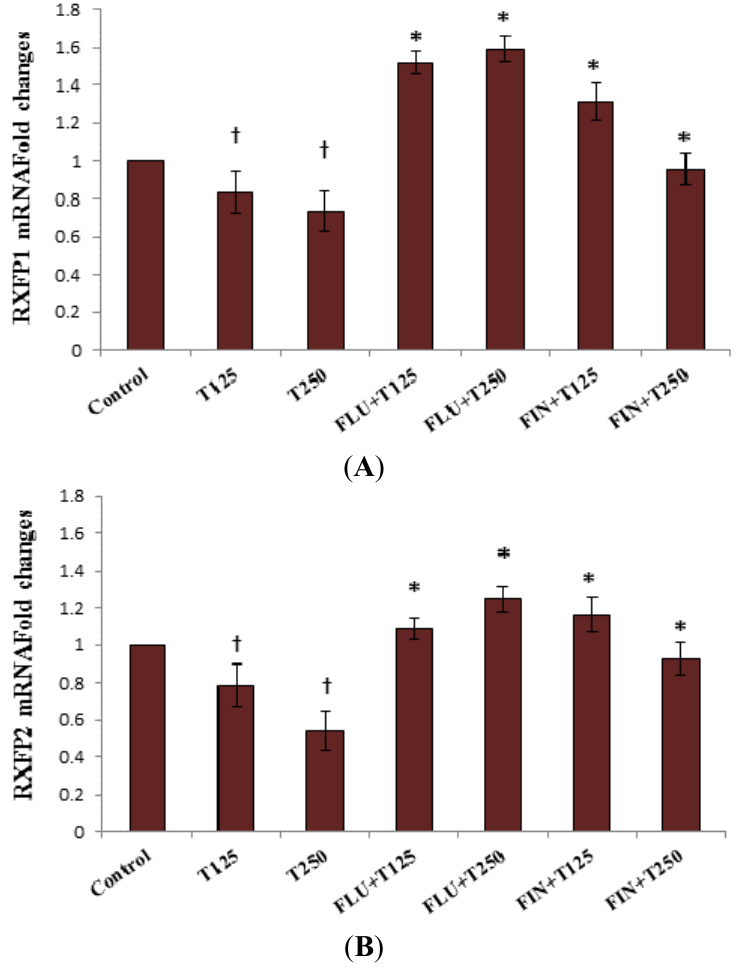
Figure 2. Changes in Rxfp1 ( A ) and Rxfp2 ( B ) mRNA expression in the presence of FLU and FIN in the patellar tendon of steroid-replaced ovariectomised rats. Treatment with 125 and 250 μ g/kg/day testosterone caused a significant decrease in Rxfp1 and Rxfp2 mRNA levels as compared to control. Administration of flutamide and finasteride significantly antagonized the inhibitory effect of testosterone on Rxfp1 and Rxfp2 expression with FLU effect relatively higher than FIN for Rxfp1 , however no significant differences were noted for Rxfp2 mRNA. † p < 0.05 as compared to control; * p < 0.05 as compared to testosterone only treatment for the respective group. T125: 125 µg/kg/day